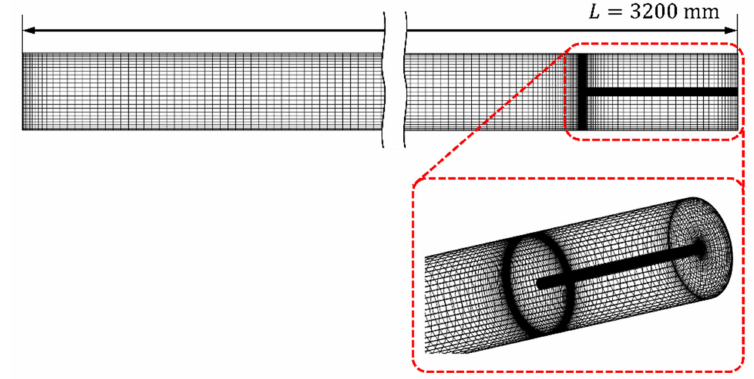
Figure 4. Grid system for numerical